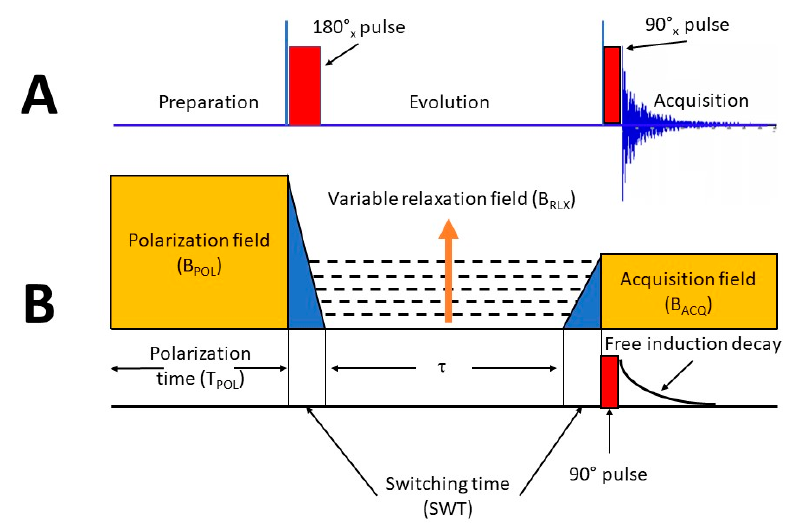
Figure 2. ( A ). Typical inversion recovery sequence applied in NMR spectroscopy to measure T 1 values. ( B ). Fast field sequence applied to obtain the T 1 values in relaxometry experiments.